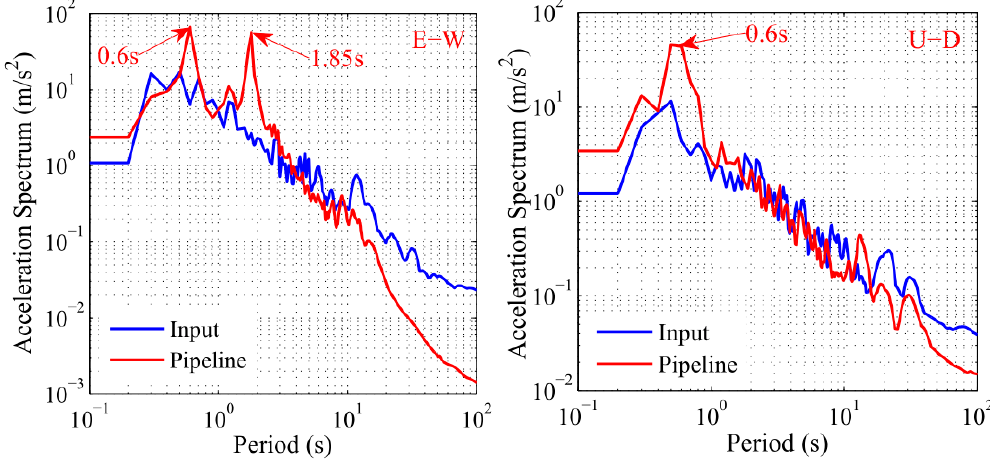
Figure 9. Acceleration spectrum of the pipeline responding to input seismic wave. It is observed that there are two resonance periods (0.6 s and 1.85 s) for the pipeline-crude oil-seabed foundation